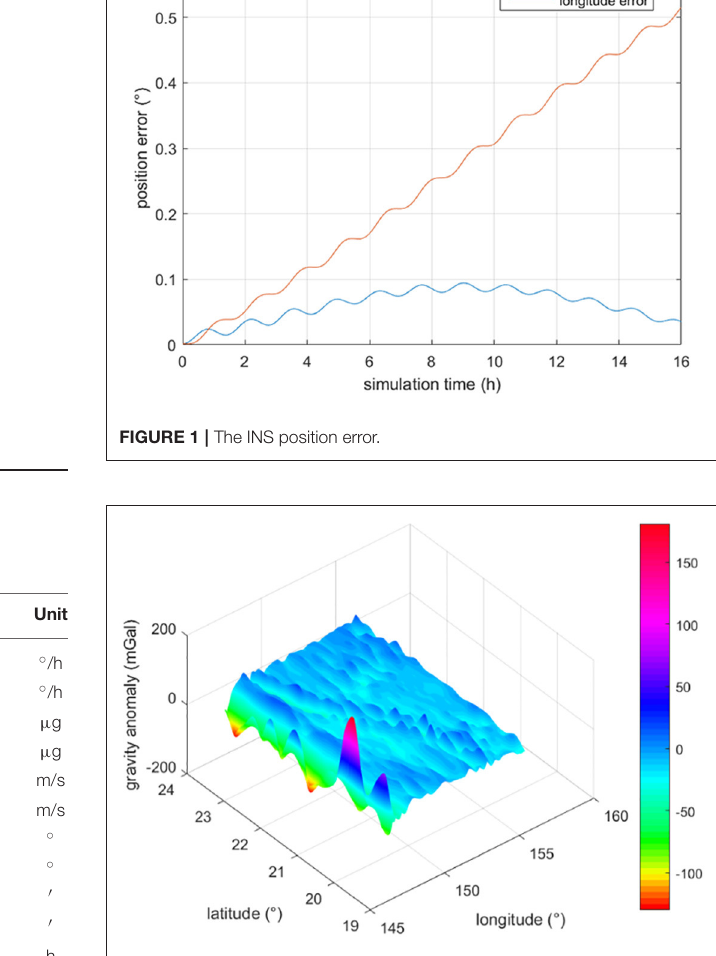
FIGURE 2 | 3-D gravity anomaly base map.